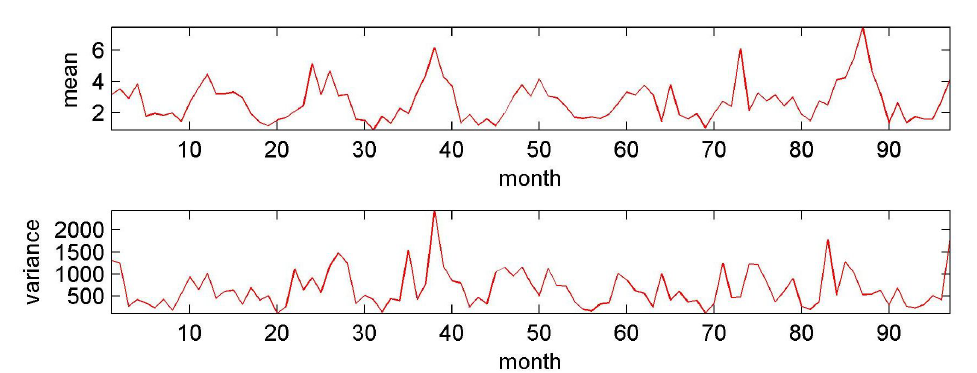
( j ) ( top ) in K and variance ext